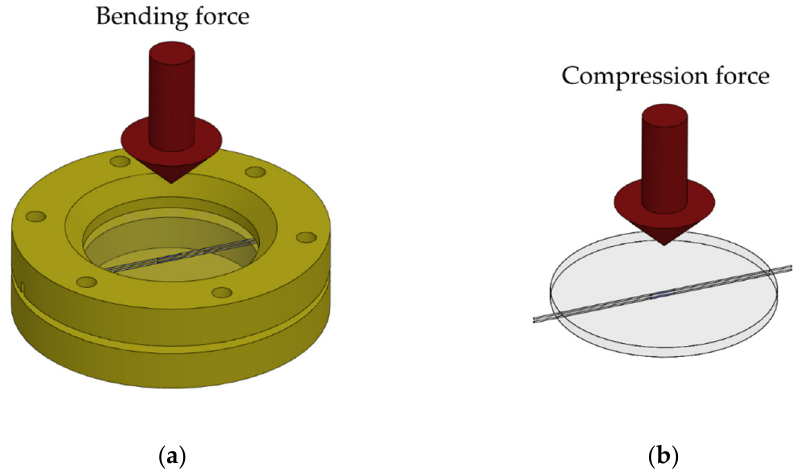
Figure 2. ( a ) Schematic representation of the experimental setup used for bending test characterizations. ( b ) Schematic representation of the experimental setup used for compression test characterizations.